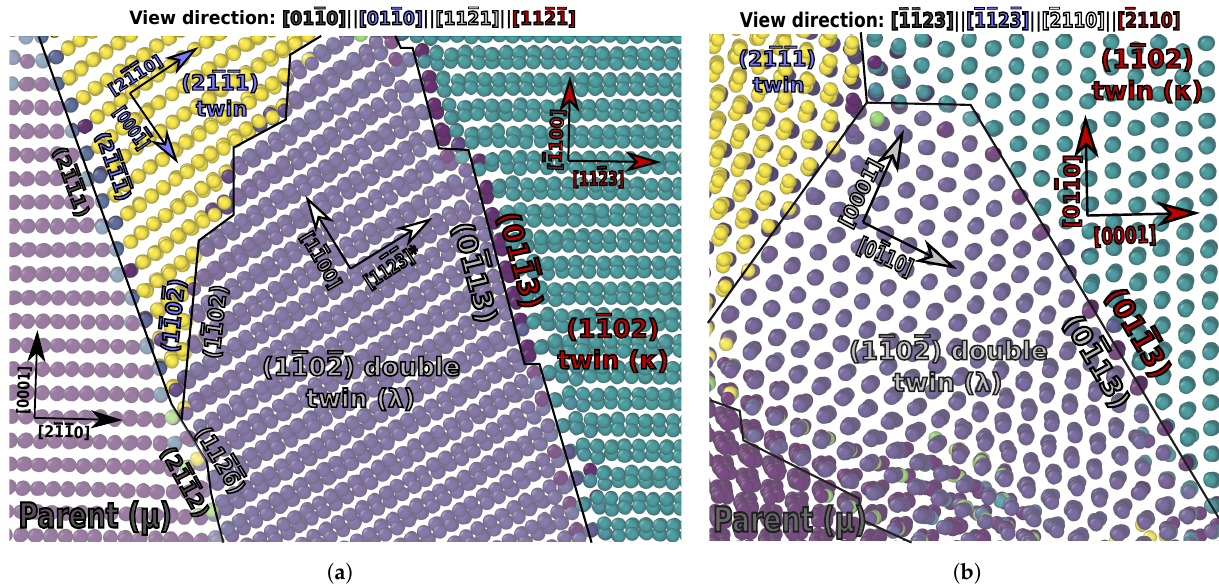
Figure 10. Interactions between ( 2111 ) - ( 1102 ) double twin and ( 1102 ) twin. All four lattice orientations are visible in the images. ( b ) shows the ( 0113 ) twin plane interface viewed from the shear plane direction, while ( a ) shows the shear plane direction for the initial ( 2111 )